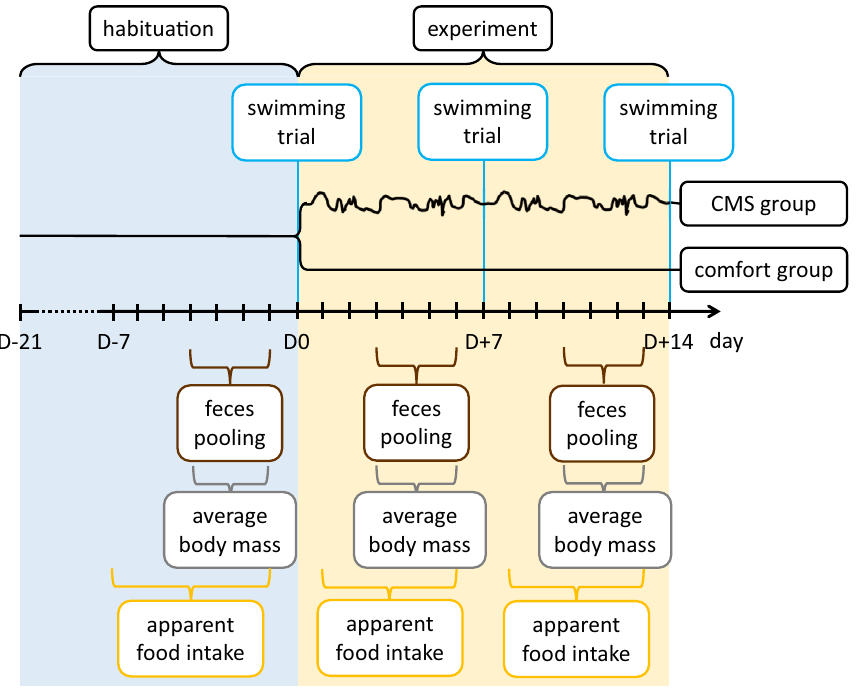
Figure 1. Schematic overview of the experimental design. At days D-21- D0 all animals were undergoing the same habituation procedure, involving daily weighing and a 20-min transfer to an empty cage allowing for feces collection. After the D0 swimming trial the experimental groups were established and the chronic mild stress (CMS) treatment was applied to the CMS group. The CMS treatment included a series of mild, unpredictable stressors (Table 1) and lasted from the night after D0 to the swimming trial at D+14. The daily manipulations introduced during the habituation period continued throughout the experiment, except in the swimming trial